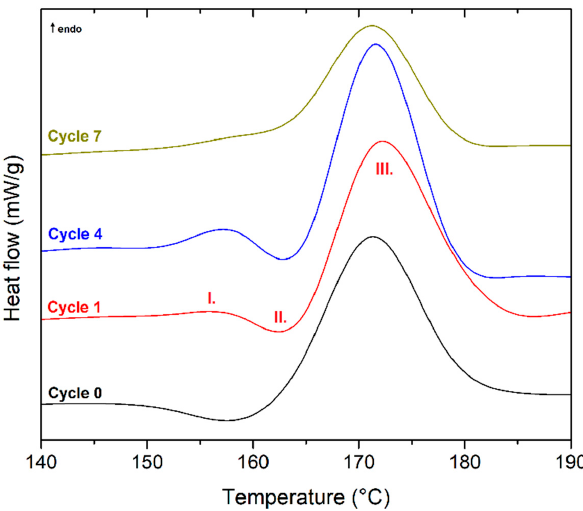
Figure 4. DSC curves (second heating) of PLLA as a function of recycling cycle.